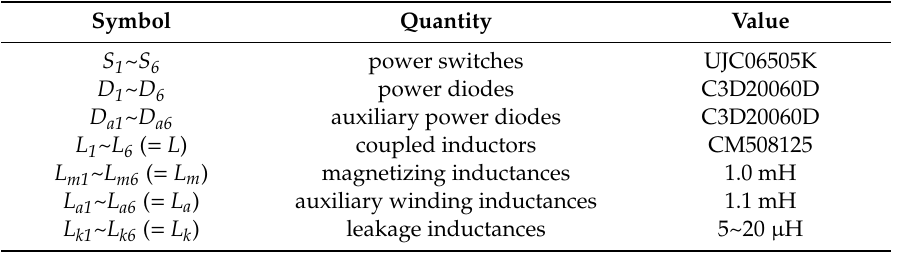
Table 2. Component parameters of the prototype